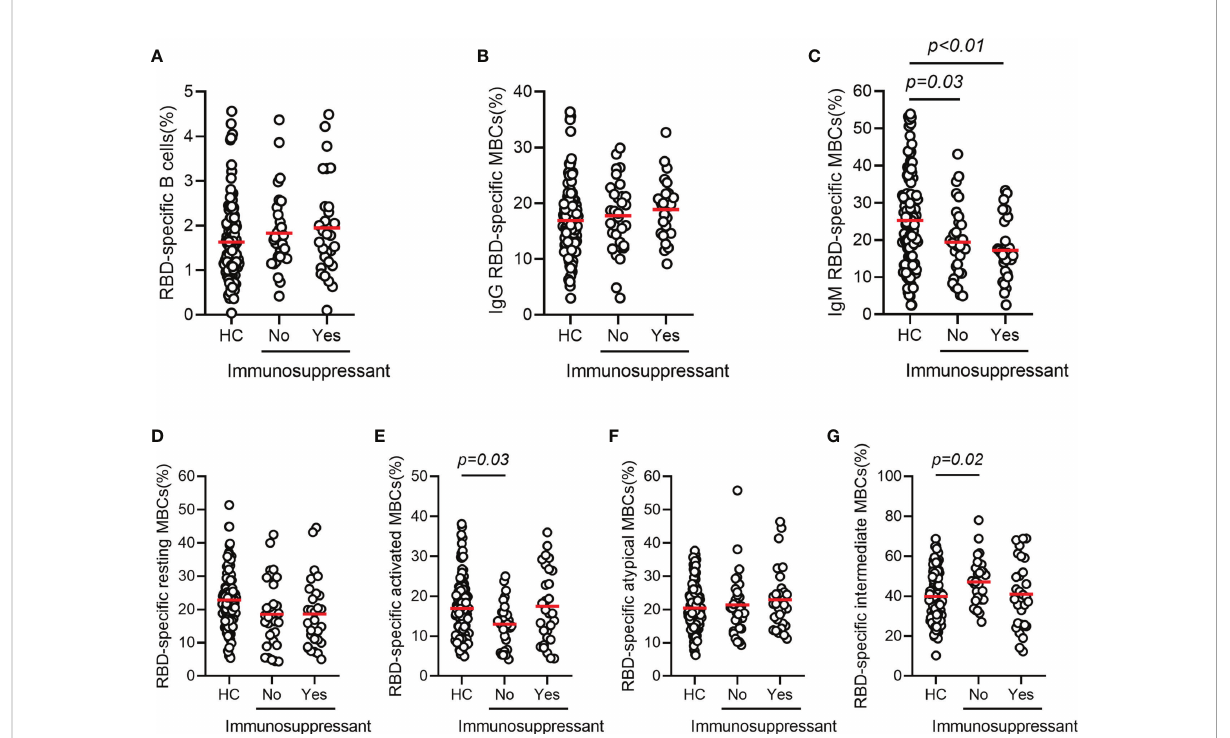
FIGURE 3 RBD-speci fi c B cell responses after COVID-19 vaccination in patients with AILD and healthy controls. Frequency of RBD-speci fi c B cells (A) , IgG RBD-speci fi c MBCs (B) , IgM RBD-speci fi c MBCs (C) , RBD-speci fi c resting MBCs (D) , RBD-speci fi c activated MBCs (E) , RBD-speci fi c atypical MBCs (F) and RBD-speci fi c intermediate MBCs (G) in patients with AILD and healthy controls. AILD, autoimmune liver disease; MBCs, memory B cells; RBD, receptor-binding